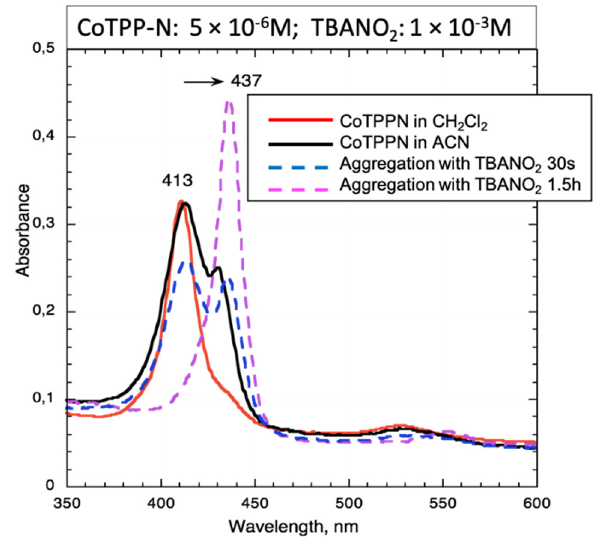
Figure 1. UV-vis spectra of CoTPP-N (5 × 10 − 6 M) in CH 2 Cl 2 (red line) and acetonitrile, ACN (black line). Dashed lines represent the evolution of CoTPP-N spectra in ACN in the presence of 1 mM TBANO 2 .